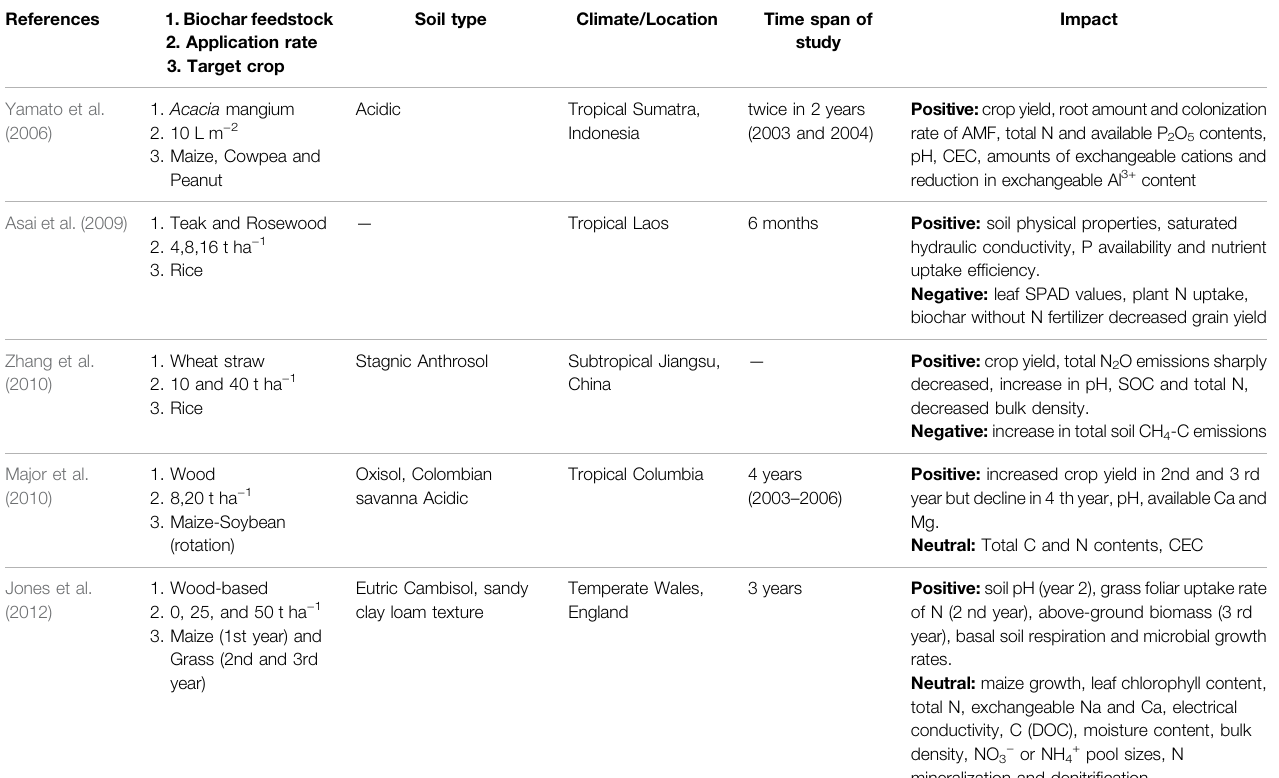
TABLE 2 | Summarised impact of biochar as observed in some fi eld